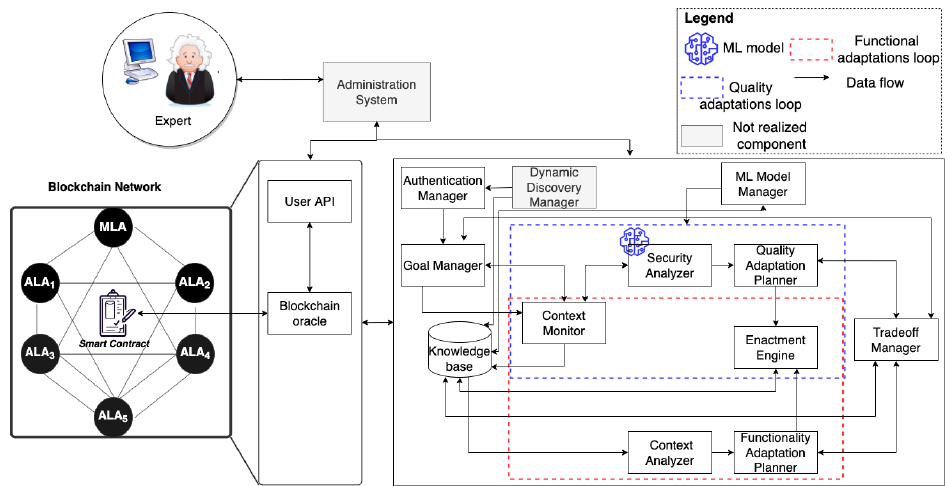
Figure 4. The software architecture of an agent and the blockchain